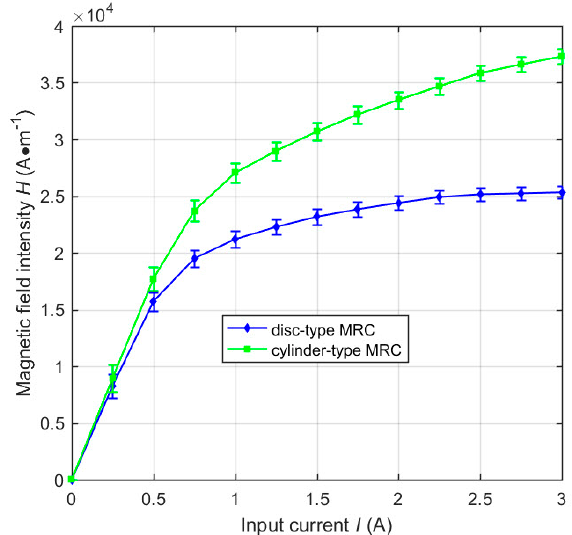
Figure 6. Relationship between the average magnetic field intensity of the working MRFs and the input current.